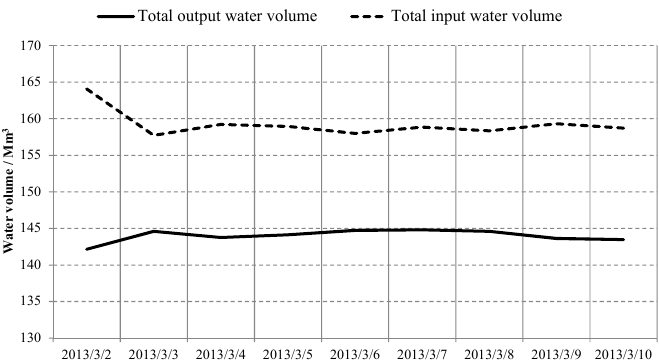
Figure 10. The water volume process of the Xili reservoir during the operation.